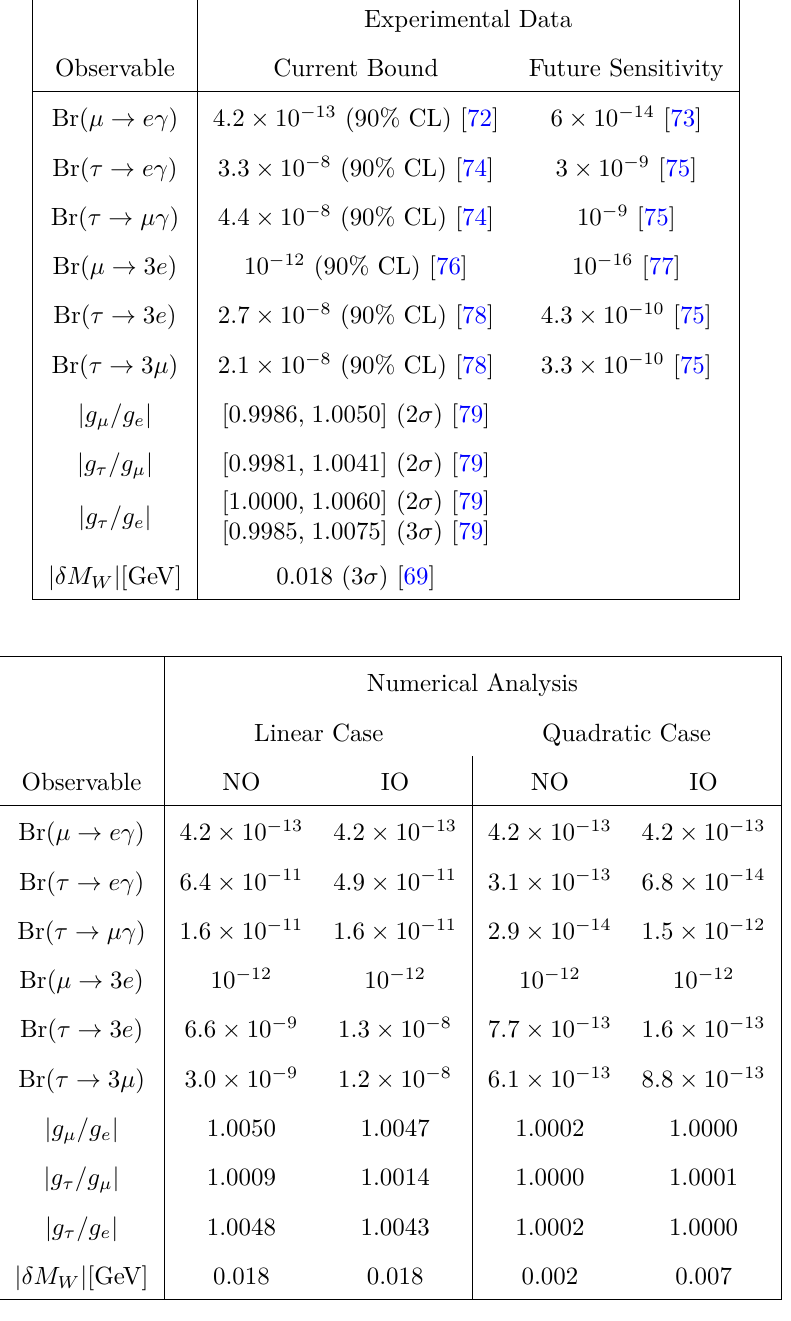
Table 2 . The upper table contains the current experimental bounds on and future sensitivities to the relevant observables. The lower table shows the respective maximum contribution found in the scan in the linear case and the quadratic case for either neutrino-mass